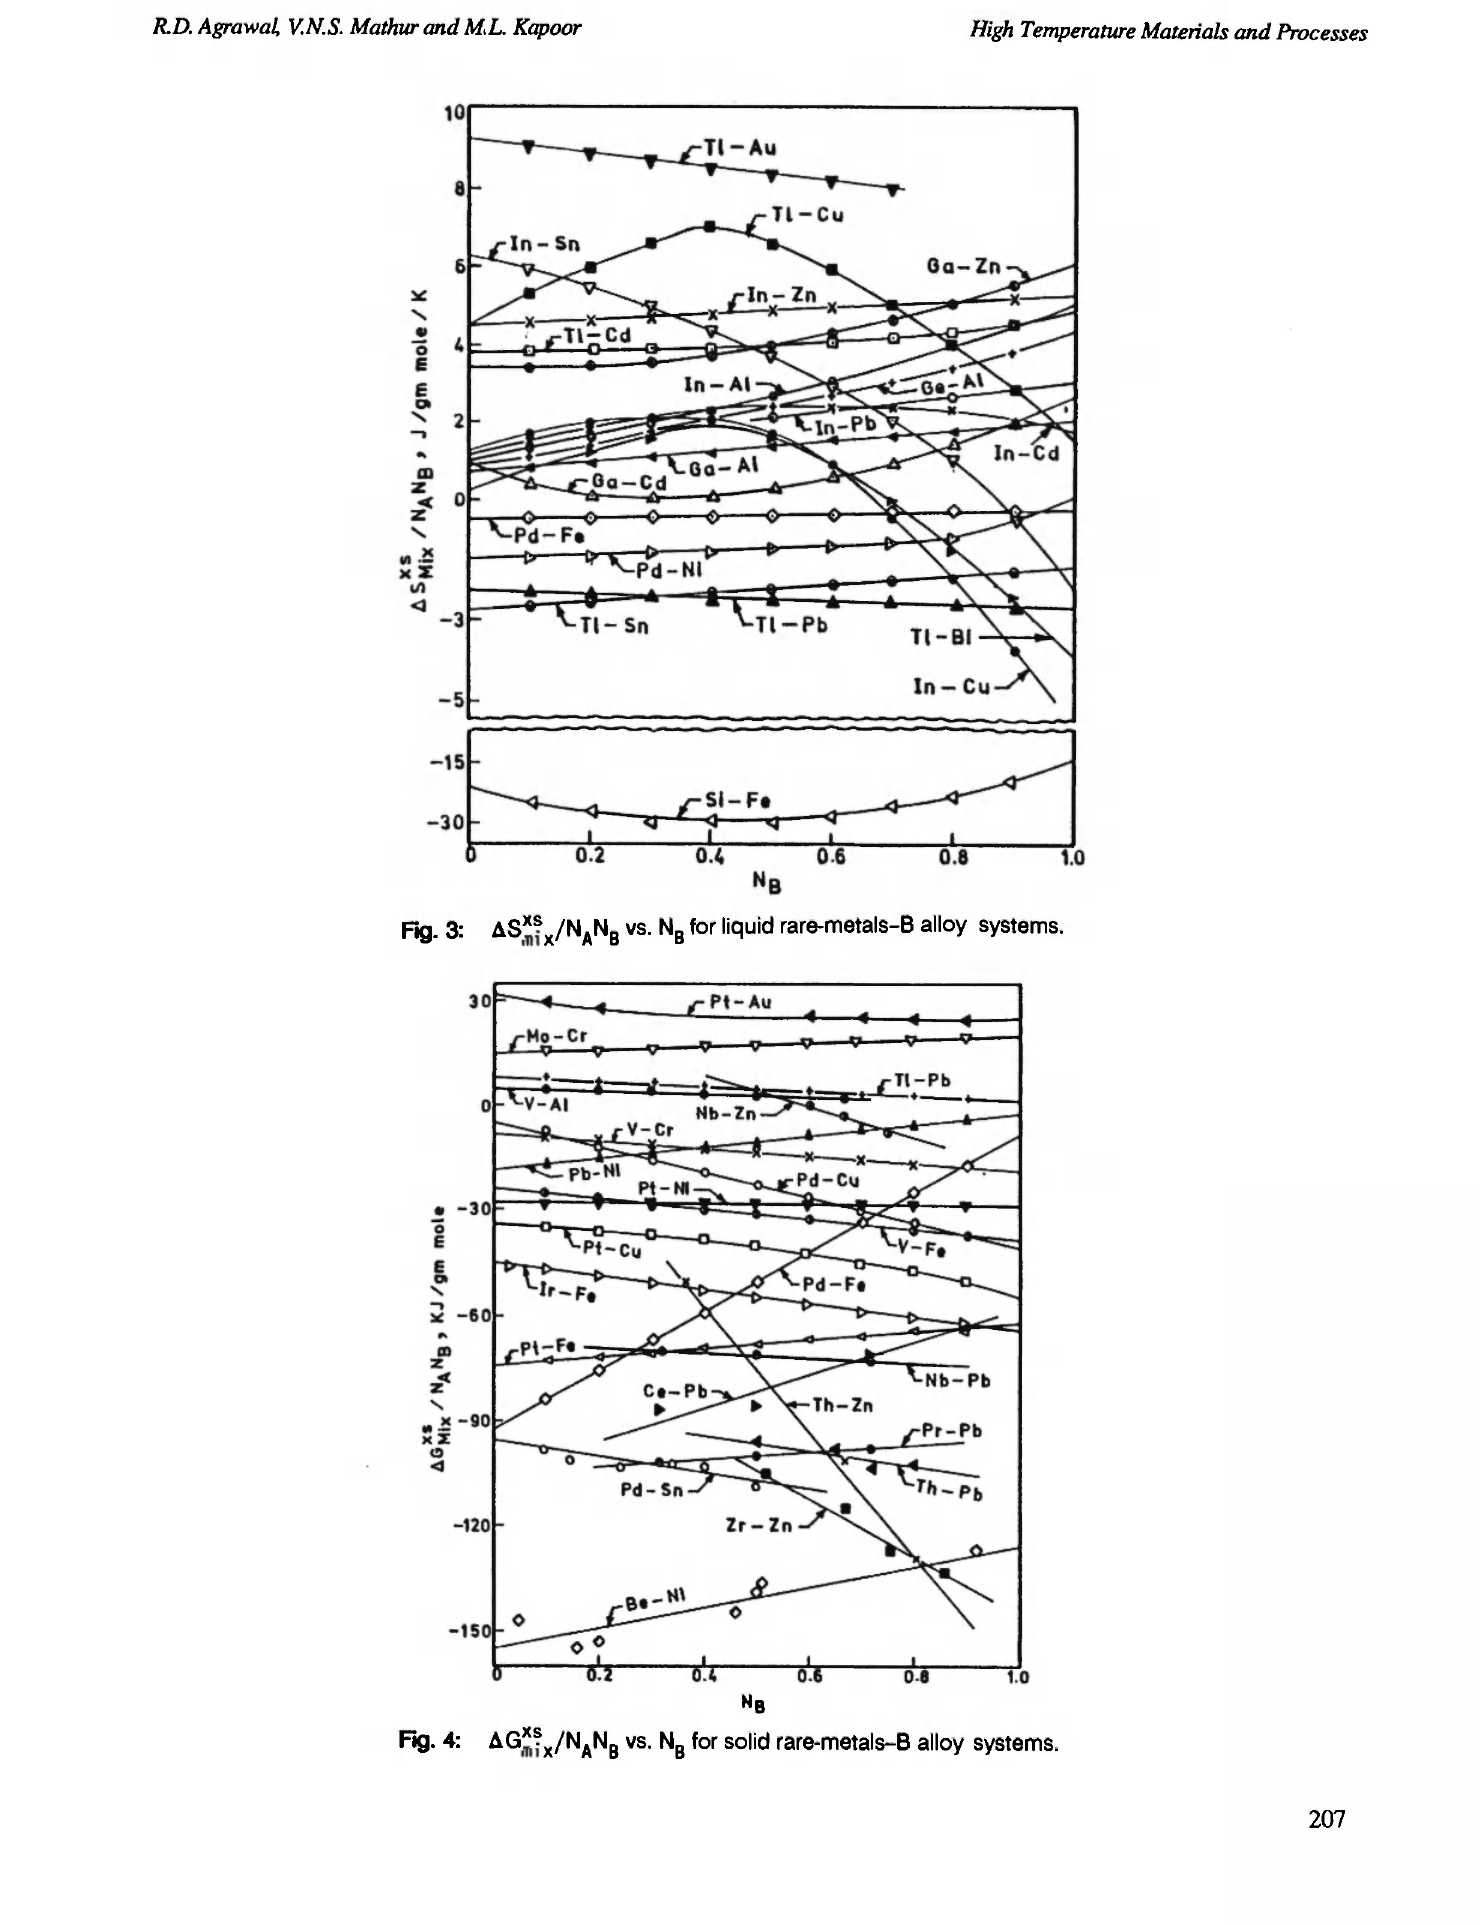
NB Fig. 4: AG*? X /N A N B vs. Ν β for solid rare-metals-B alloy systems.